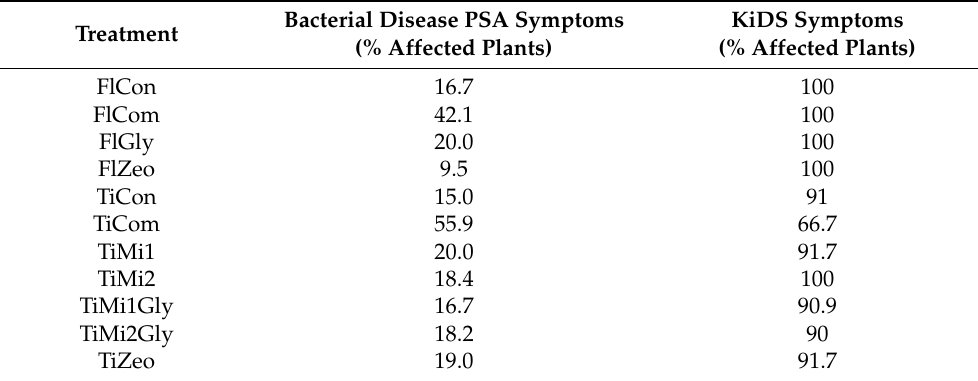
Table 1. Bacterial disease PSA and KiDS symptoms occurrence expressed as affected plants percentage of 23 total plants detected per each treatment at the end of third year vegetative season.